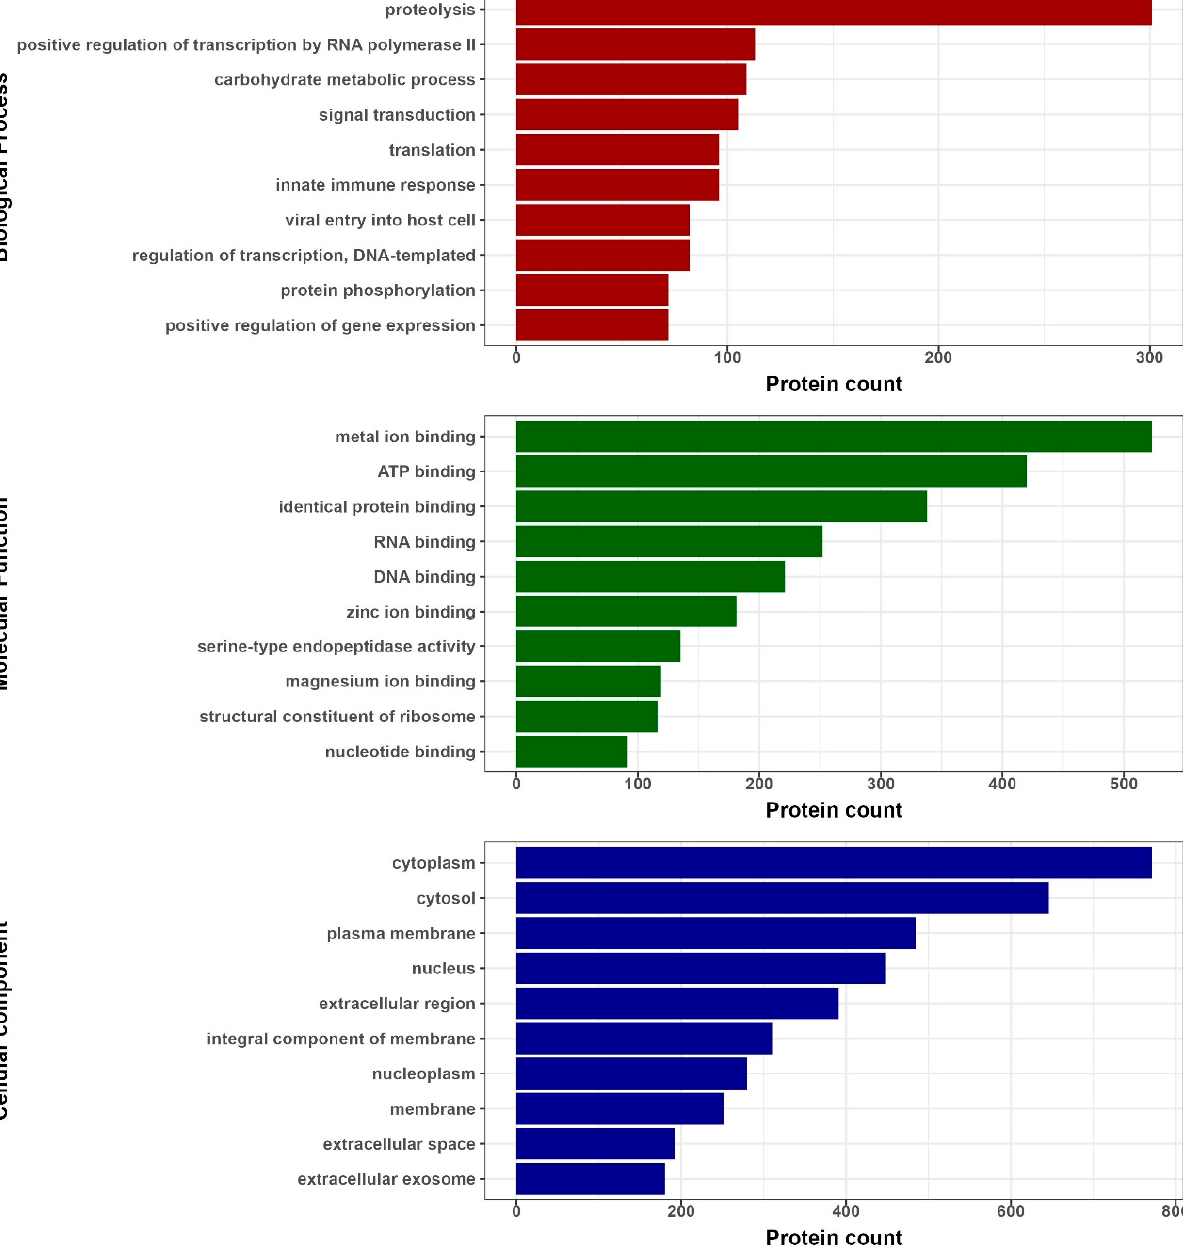
Figure 5. Biological functions of proteins in which the 3 β -corner motif was identified. Green bars correspond to molecular processes (MF), red bars correspond to cell compartments (CC), and blue bars correspond to molecular functions (MF).